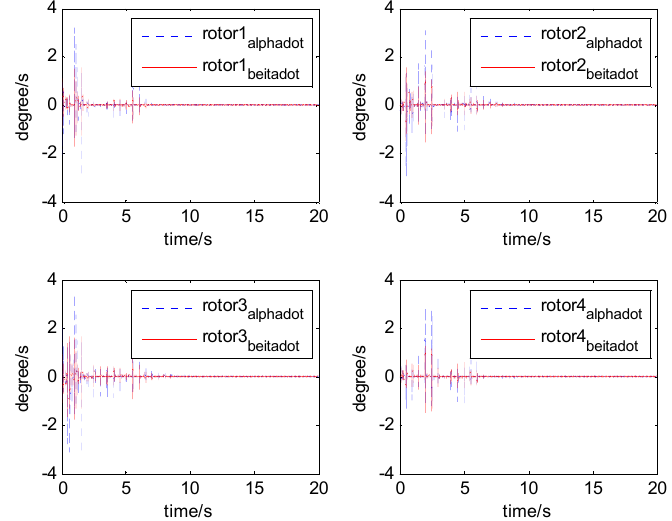
Figure 23. The magnetically suspended rotor angle velocity relative to rotor center after